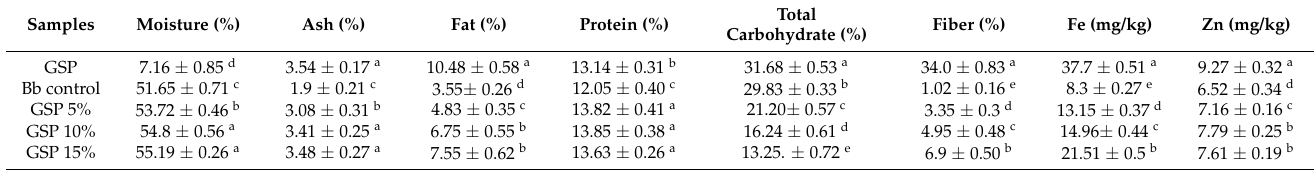
Table 2. Chemical composition of grape seed powder (GSP), balady bread (Bb) control, and balady bread supplemented with different concentrations of